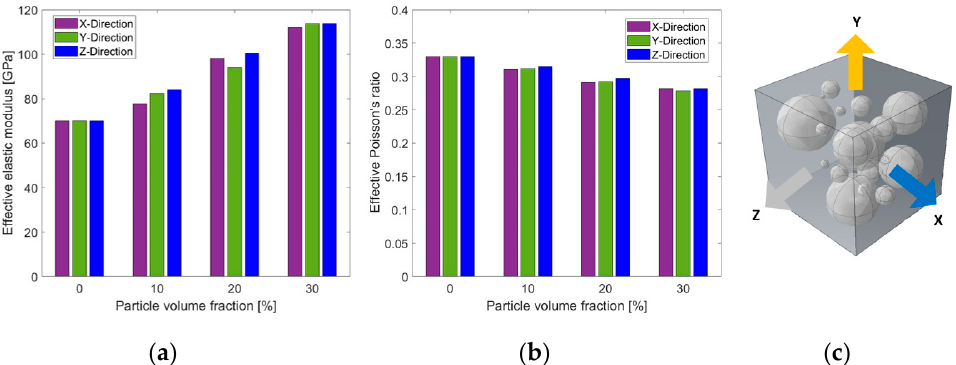
Figure 6. Effective elastic modulus ( a ) and Poisson’s ratio ( b ) obtained from RVEs under uniaxial tension ( c ) and fully bonded conditions for different particle volume fractions and loading direc- tions.